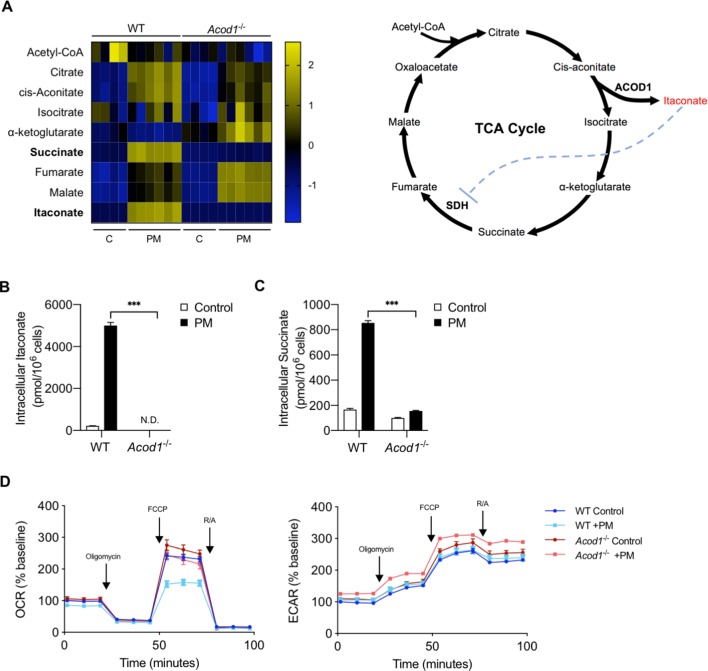
Acod1 and endogenous itaconate production is required for PM-reduced mitochondrial OCR via inhibition of SDH.(A) Heatmap of intracellular levels of TCA cycle metabolites and itaconate at 24 hours following treatment with PM. (B–C) Intracellular concentrations of (B) itaconate and (C) succinate in WT and Acod1-/- cells with (n = 6) and without (n = 4) PM; itaconate is not detectable in Acod1-/- cells, while succinate does not accumulate in Acod1-/- cells. (D) Mitochondrial stress test of WT and Acod1-/- BMDMs after 24 hours of PM treatment. OCR was normalized to baseline OCR in WT control BMDMs (untreated). Maximal OCR levels are only decreased in WT cells, and not Acod1-/- cells following PM. Significance was analyzed with one-way ANOVA corrected with Bonferroni’s post hoc test for multiple comparisons, *p<0.05, **p<0.01, ***p<0.001.